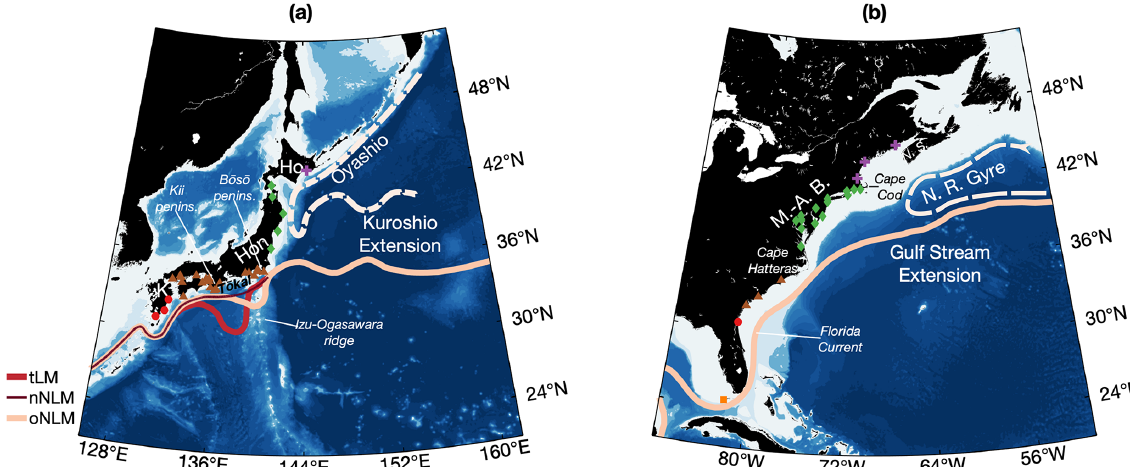
Figure 1. (a) Kuroshio region circulation: the three Kuroshio paths – the typical large meander (tLM), the nearshore non-large meander (nNLM) and the offshore non-large meander (oNLM) are indicated upstream of the Izu–Ogasawara Ridge. The mean location of the KE is indicated offshore of this point, showing the location of the quasi-stationary meanders. The Oyashio current is shown in dashed pink. On land, K indicates Ky¯ush¯u, Hon stands for Honsh¯u and Ho indicates Hokkaid¯o. (b) Gulf Stream region circulation from the Florida Current to the Gulf Stream Extension. The Northern Recirculation Gyre is also indicated. On land, MAB stands for Mid-Atlantic Bight and NS indicates Nova Scotia. Markers in (a) and (b) indicate the location of the tide gauges used in this study. The colour and shape of the markers in (a) and (b) indicate the angle used to rotate the wind stress in an alongshore and across-shore coordinate system for the removal of sea-level variability driven by local atmospheric effects (see Tables S1 and S2 in the Supplement). Shading in (a) and (b) indicates